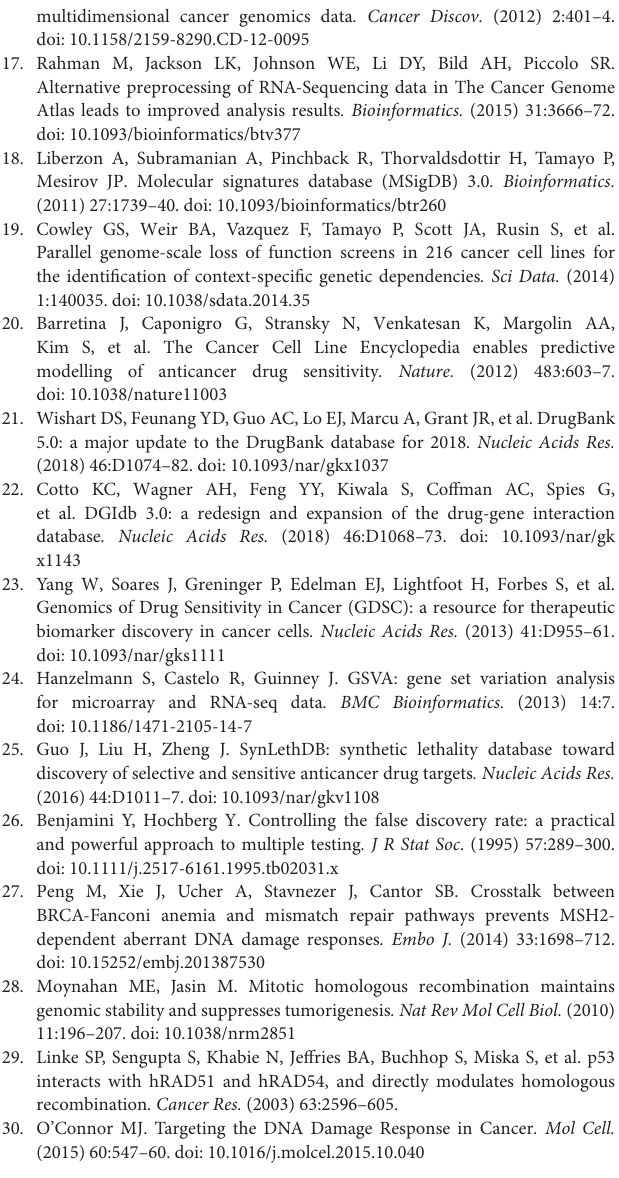
Supplementary Figure 1 | Mutually exclusive mutations of DDR genes representing three different DDR clusters (from Figure 3A ) is shown for 15 tumor types. Supplementary Table 1 | This table contains a filtered list of the literature reported and predicted synthetic lethal interactions of DDR genes from 3 clusters in TCGA tumor types. The synthetic lethal interactions presented in this table has the following filters: (1) the primary gene (Gene1) has mutation in at-least 5 tumor samples from the corresponding TCGA tumor type (2) the primary gene (Gene1) and the synthetic lethal gene (Gene2) has significant conditional essentiality from the Achilles shRNA screening data ( p < 0.1) (3) there is significant difference in survival between patients having high or low expression of the synthetic lethal gene (Gene2) in presence of mutation in Gene1 ( p < 0.1) (4) there is significant difference in drug sensitivity for drugs targeting Gene2 in cell lines with or without mutation in Gene1 ( p <